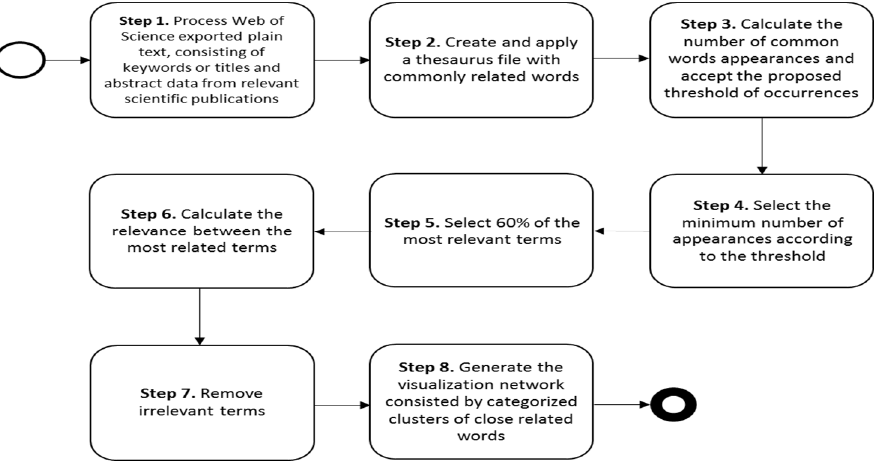
Figure 1. Main steps of the txt mining process using VosViewer.